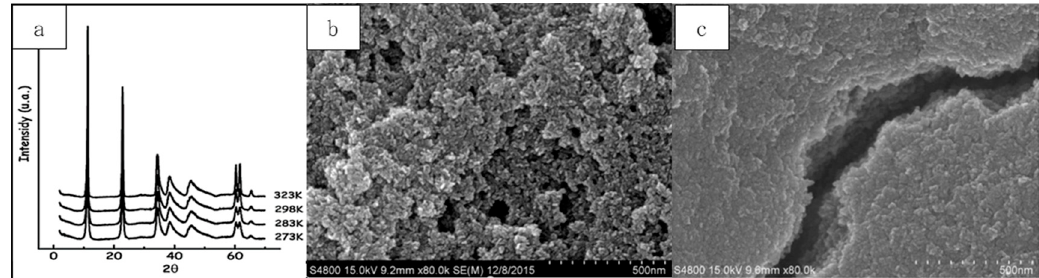
Figure 3. The variation of the XRD patterns ( a ) and the morphology ( b , c ) of NiAl-LDH prepared by coprecipitation with ( b ) and without ( c ) the ultrasonication. Reproduced with permission from reference [86,87].